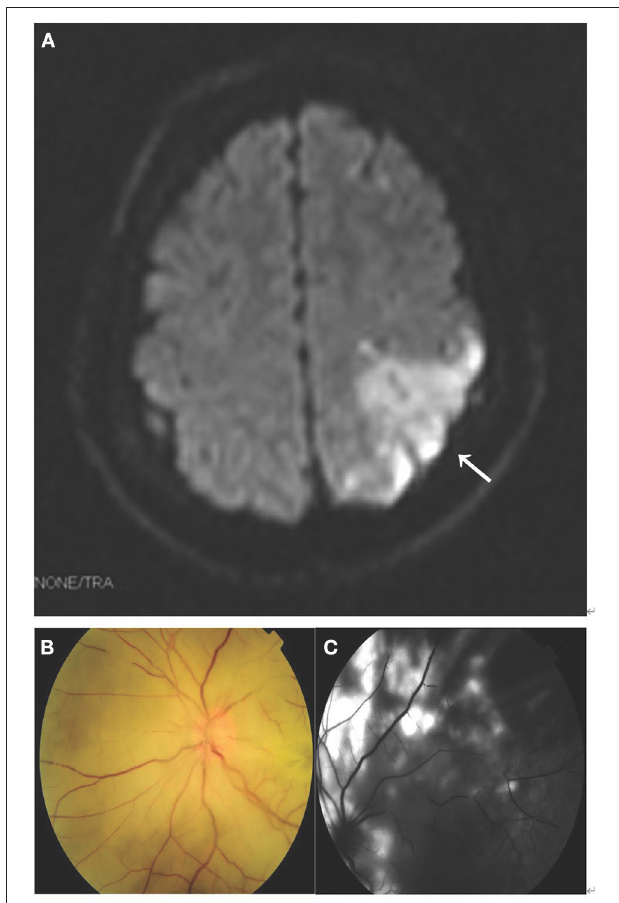
FIGURE 2 | MRI, fundus photography, and fundus fluorescence angiography of case 2. (A) Diffusion-weighted MRI showed high signal intensity in the left parietal lobe (arrow). (B) Left funduscopic examination showed an edematous optic disc and widespread retinal whitening, with multiple retinal arterioles segmentally occluded by fat emboli. The posterior pole was pale yellow. (C) Left fluorescein angiography showed blockage of the retinal arterioles and lack of perfusion of the tissue bed in hypofluorescent